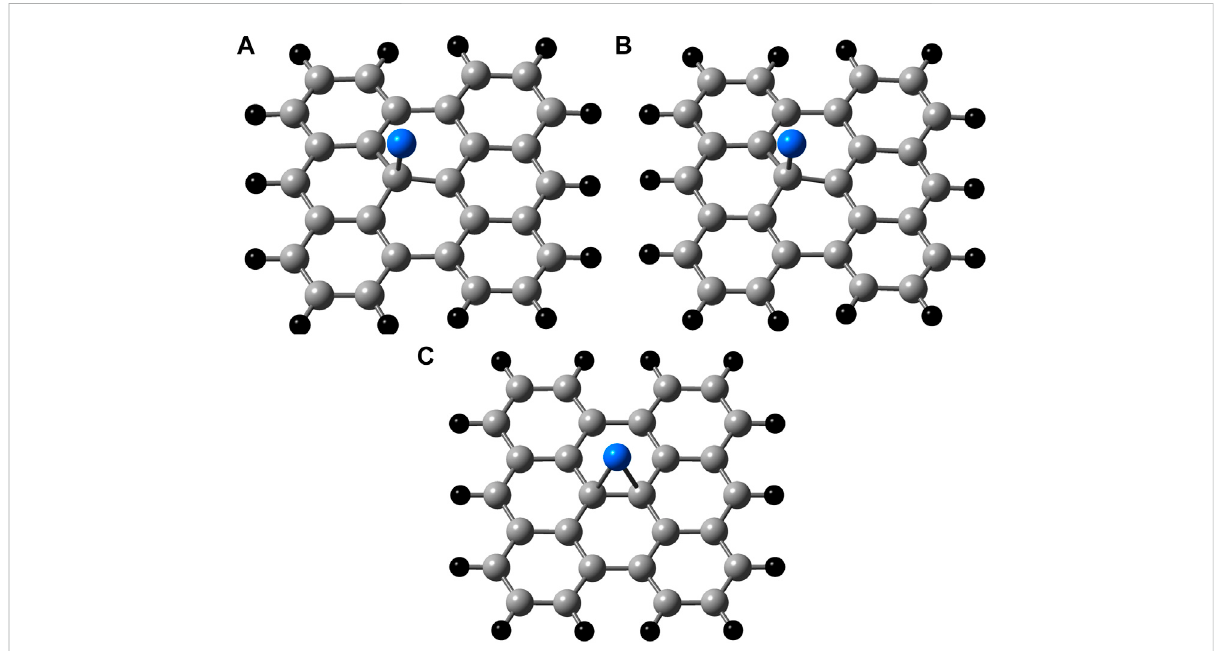
FIGURE 3 Binding sites on C 28 H 14 calculated using (A) B3LYP/cc-pVDZ (B) wB97XD/cc-pVDZ, and (C) PBE/cc-pVDZ methods. Carbon = Grey, Hydrogen = Black, and Boron = Blue.